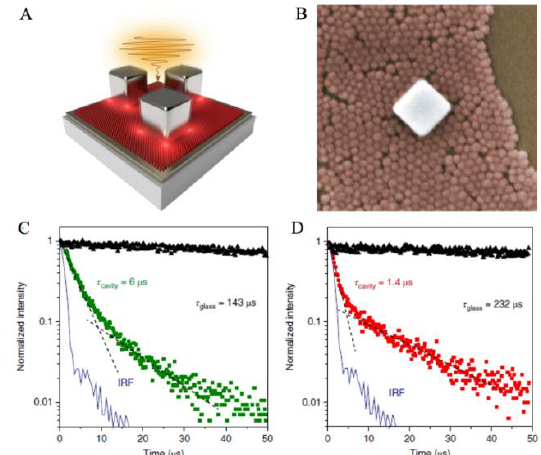
Figure 6. ( A ) Schematic of plasmonic cavity. ( B ) Scanning electron microscopy (SEM) image observed from a typical plasmonic cavity (scale bar, 100 nm). ( C ) Comparison of luminescence decay for up conversation nanoparticles (UCNPs) deposited on a glass slide (black) and on the nanocavity mode (green) for the emission at 554 nm. ( D ) Comparison of the luminescence decay for UCNPs deposited on a glass slide (black) and on the nanocavity mode (red) for emission at 660 nm. Reference [179].